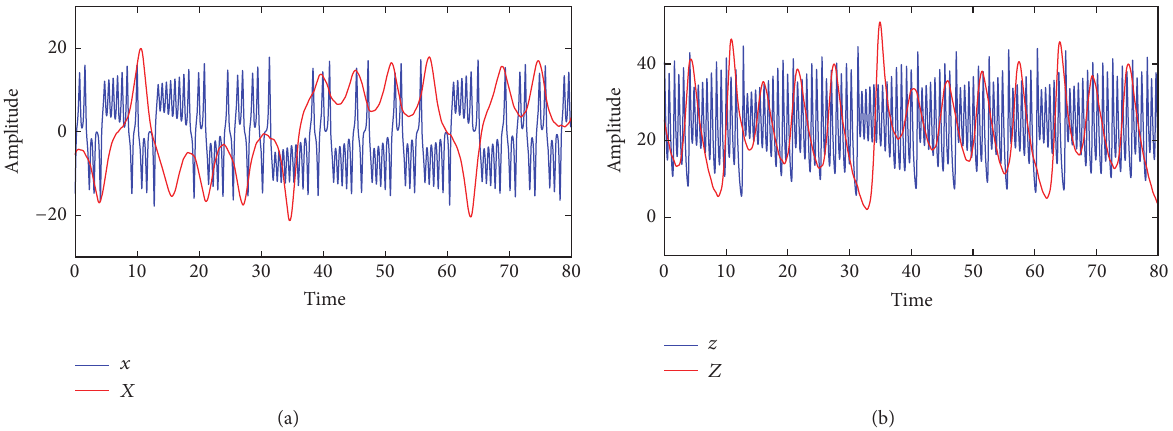
Figure 1: Fast ( 𝑥 and 𝑧 ) and slow ( 𝑋 and 𝑍 ) variables for the case of 𝑐 = 0.15 .